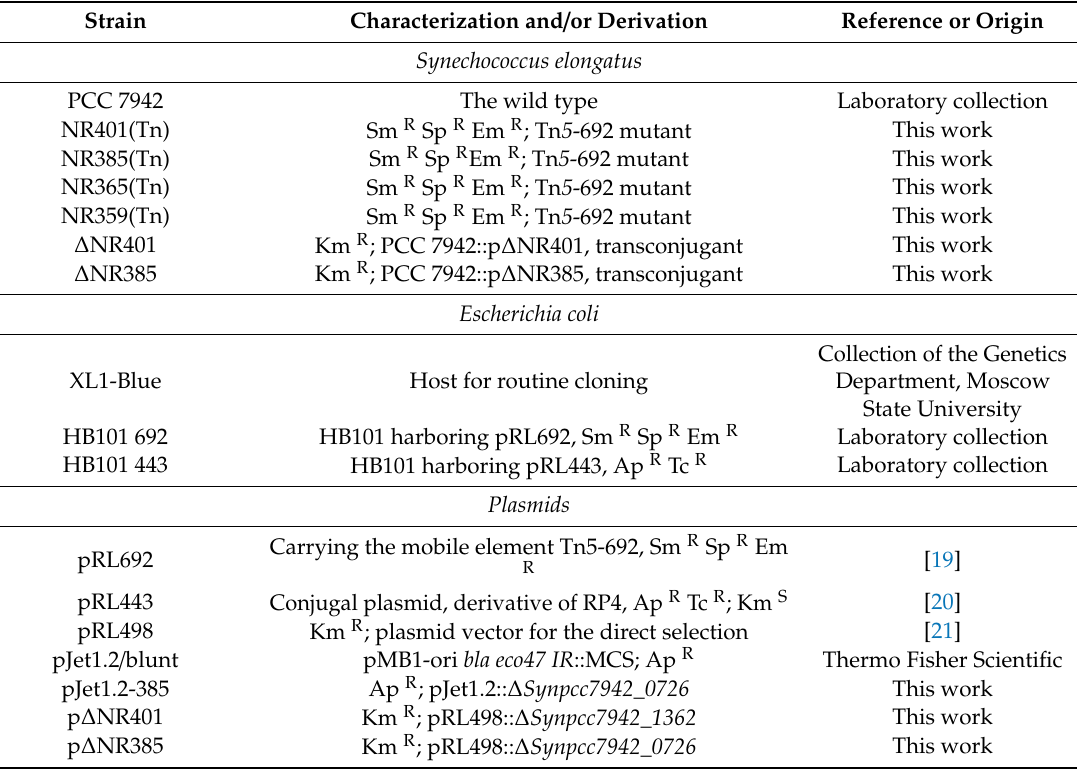
Table 1. Characteristics of bacterial strains and plasmids used in the